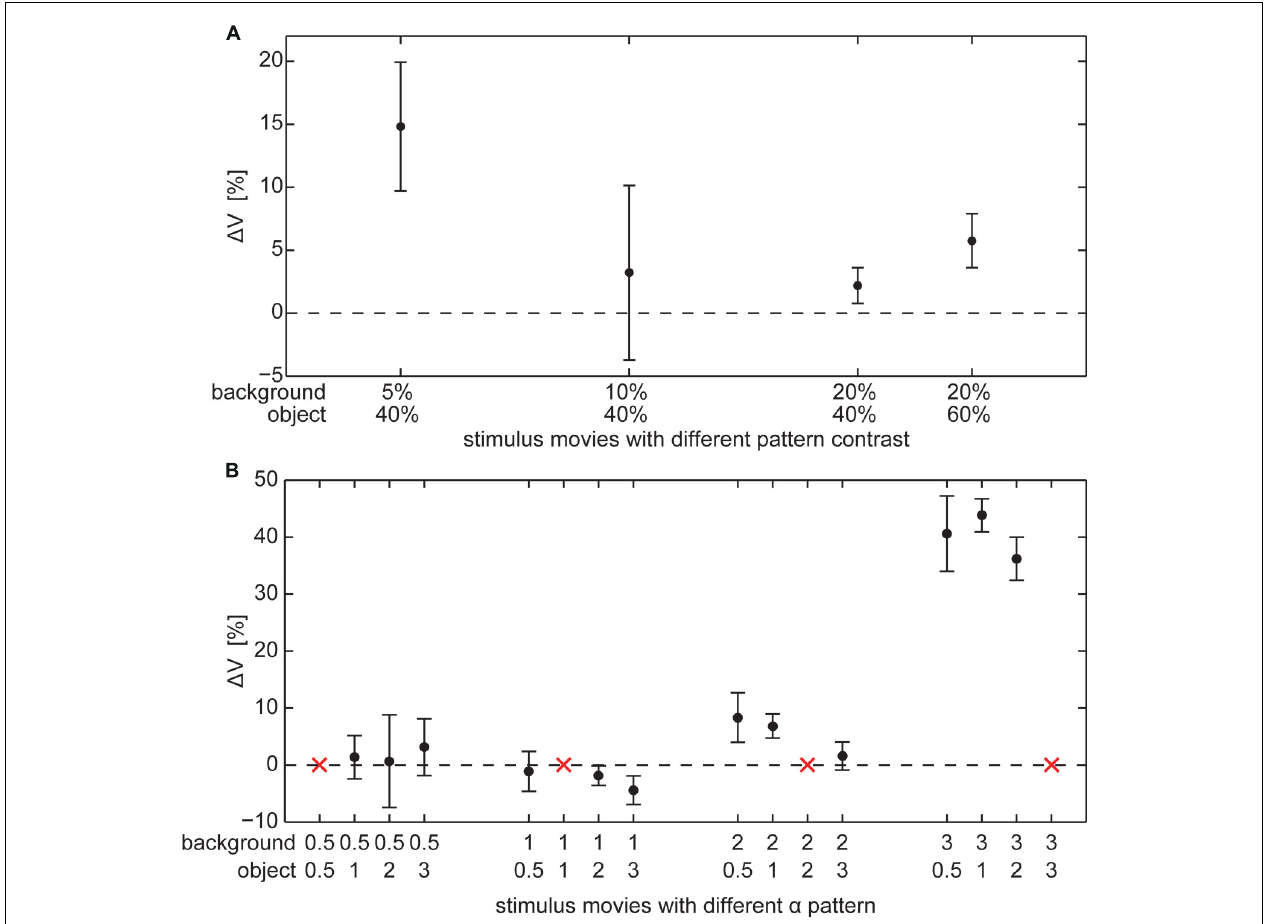
(B) for object and background textures defined by different combinations of spatial frequency ( α of object and background texture are given below the x -axis).The red “ x ” indicate those combinations where object and background have the same texture and, thus, a zero-response is expected (this condition was not measured to save recording